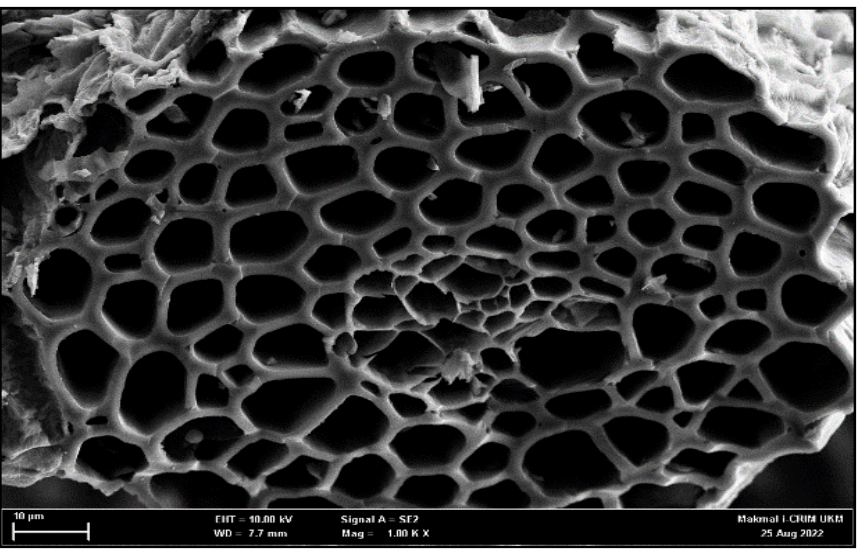
Figure 10. SEM image (at 10 µm scale) of prepared activated carbon at 1000×